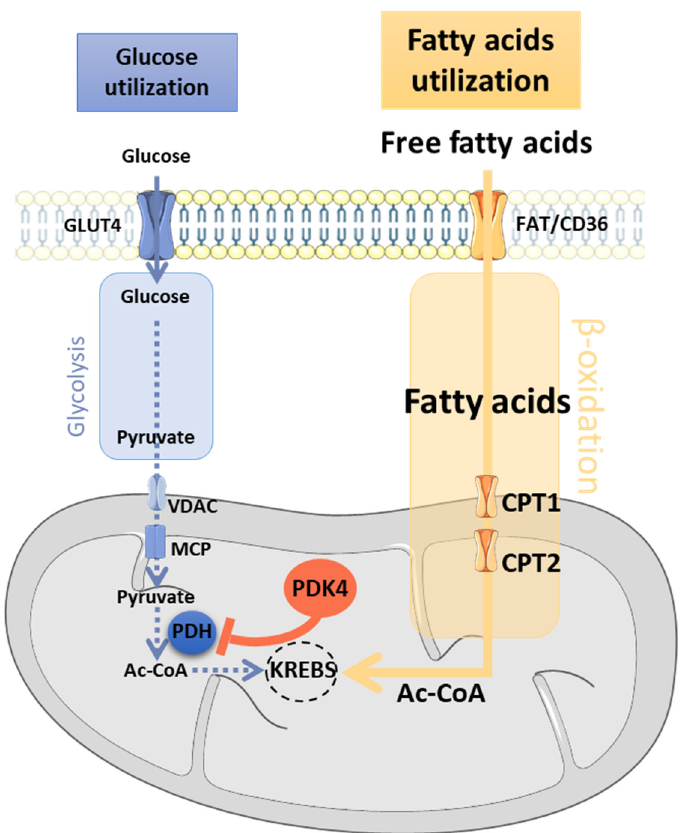
Figure 2. Altered energy metabolism in ALS skeletal muscle. In skeletal muscle, glucose enters into the cell through the GLUT4 transporter. It is then either stored as glycogen (not shown) or phosphorylated to give rise to pyruvate, the final product of glycolysis. Once formed, pyruvate enters into the mitochondria through a series of specific carriers (outer membrane: VDAC, inner membrane: MPC). In the mitochondria, pyruvate is oxidized into acetyl-CoA by PDH before entering the Krebs cycle to produce energy. Fatty acids enter the cell via FAT/CD36 transporters and get into the mitochondrial matrix thanks to CPT1 where β -oxidation will begin and produce acetyl-CoA which produces energy once in the Krebs cycle. In ALS, the oxidative pathway is greatly enhanced while the glycolytic pathway is reduced by abnormal induction of PDK4 in skeletal muscle which inactivates PDH by phosphorylation. PDK4 is believed to be at the root of this energy imbalance.